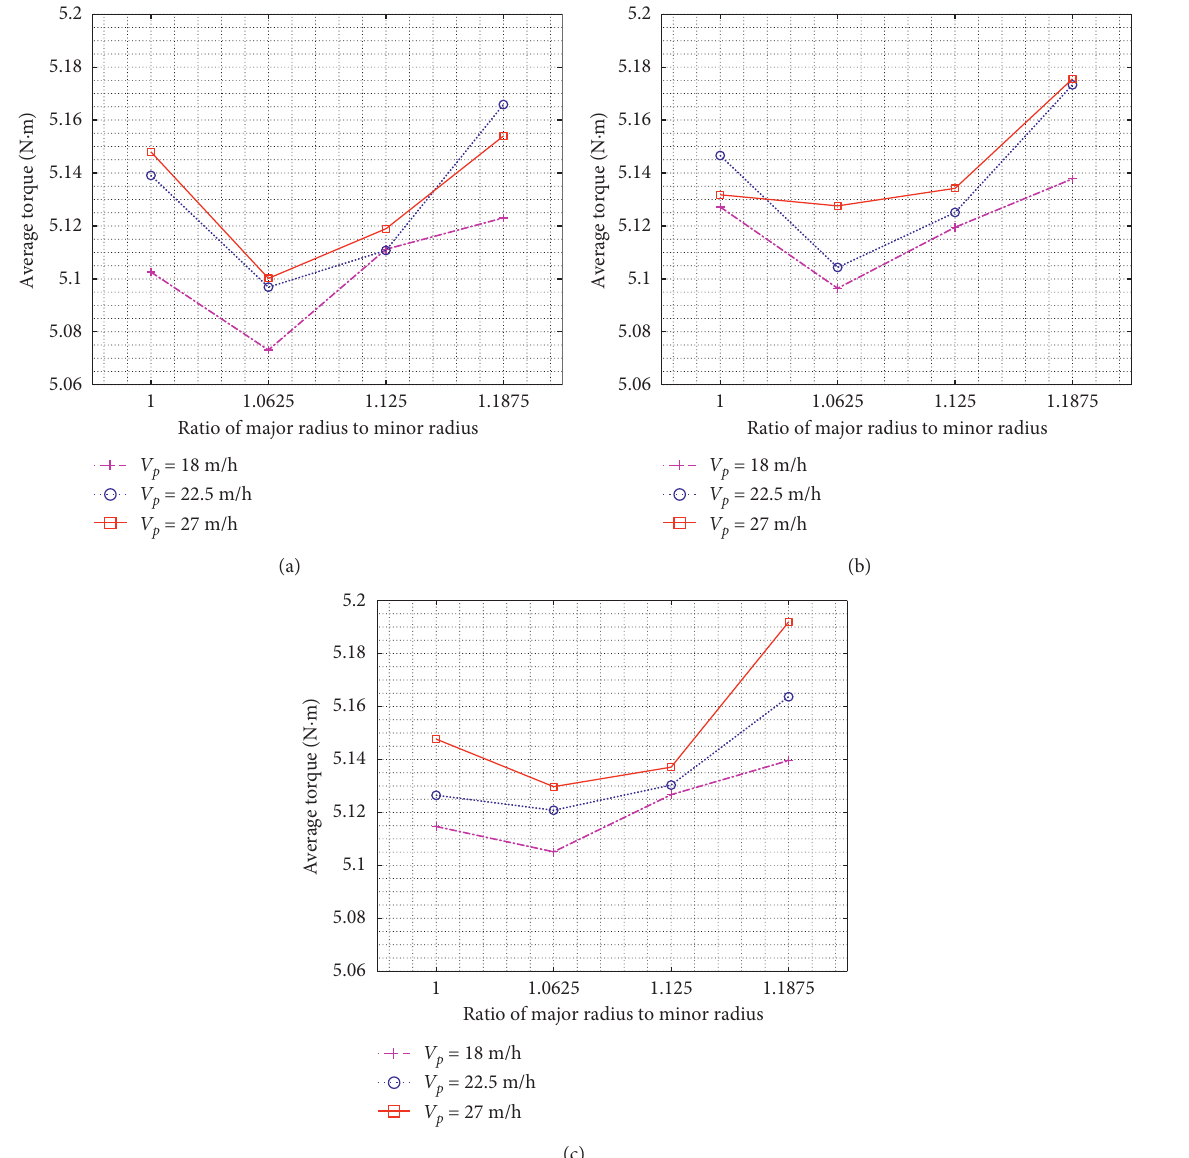
Figure 5: Curves of the average of torque changing with R Rotation speed V r �